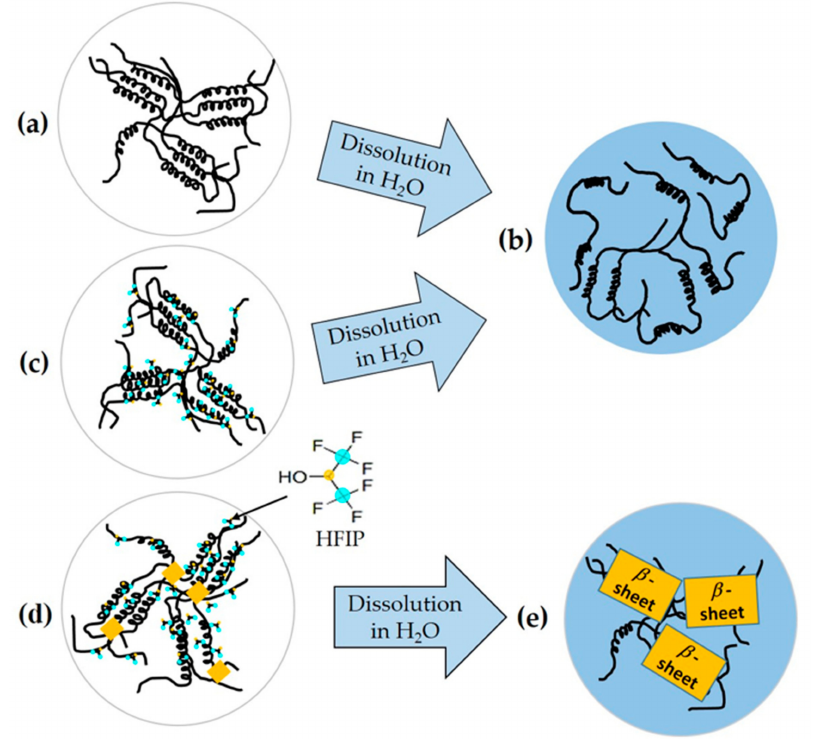
Figure 8. The LF aq as-cast film has an ordered aggregated α -helix structure ( a ) that easily dissolves in water ( b ). When treated with HFIP gas, the aggregated α -helices in the LF aq as-cast film and